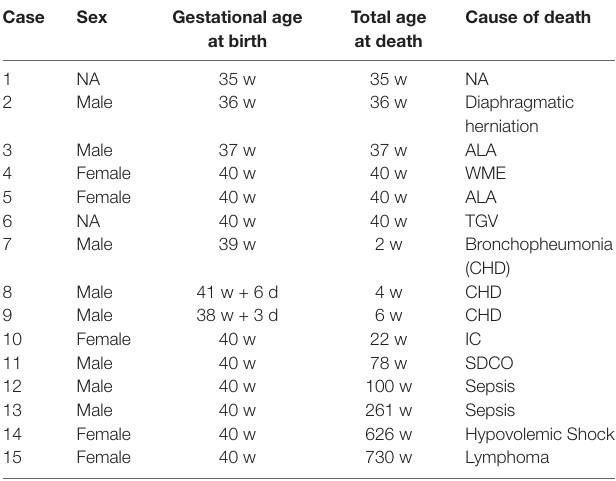
TABLE 1 | Series of cases analyzed in this